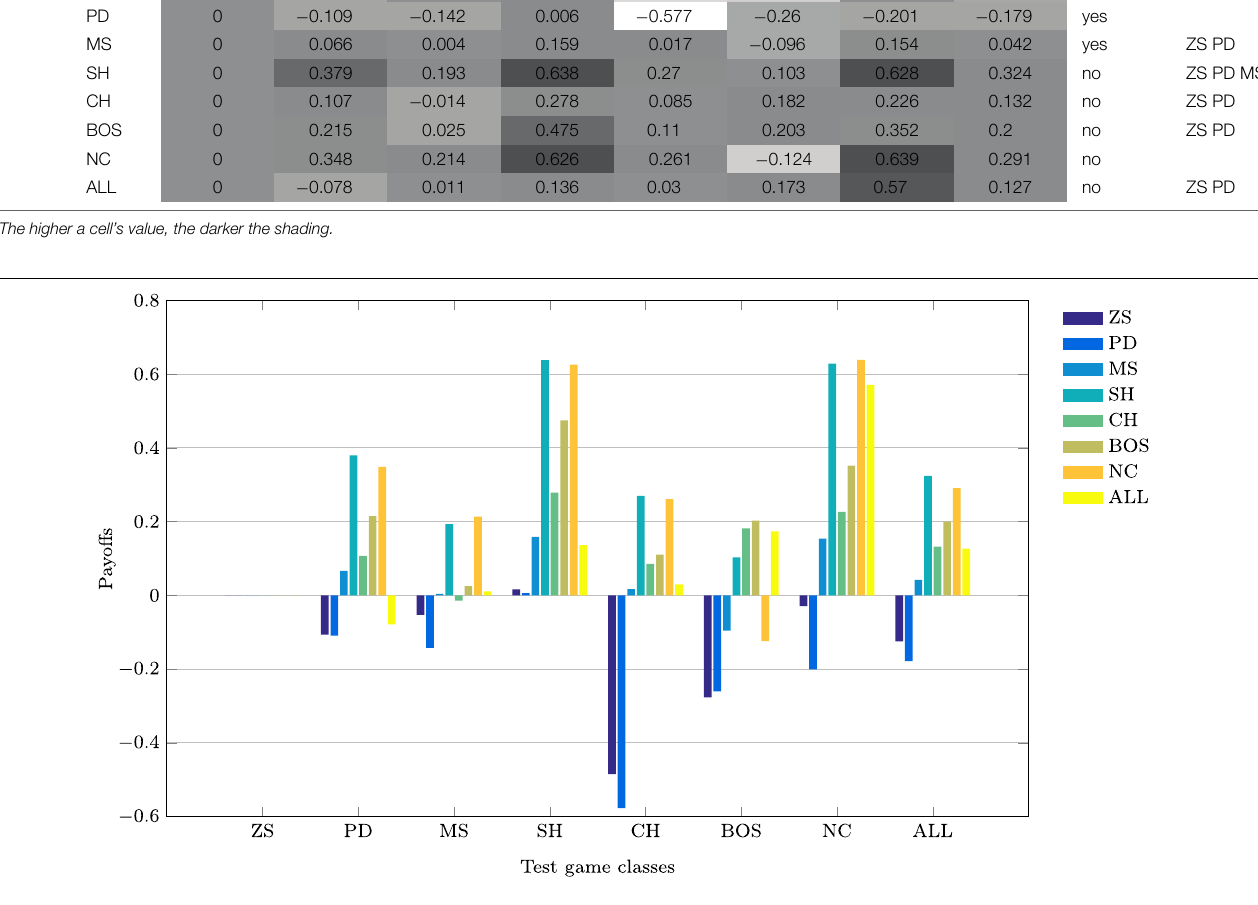
FIGURE 2 | Mean payoffs (conditional on the training and test